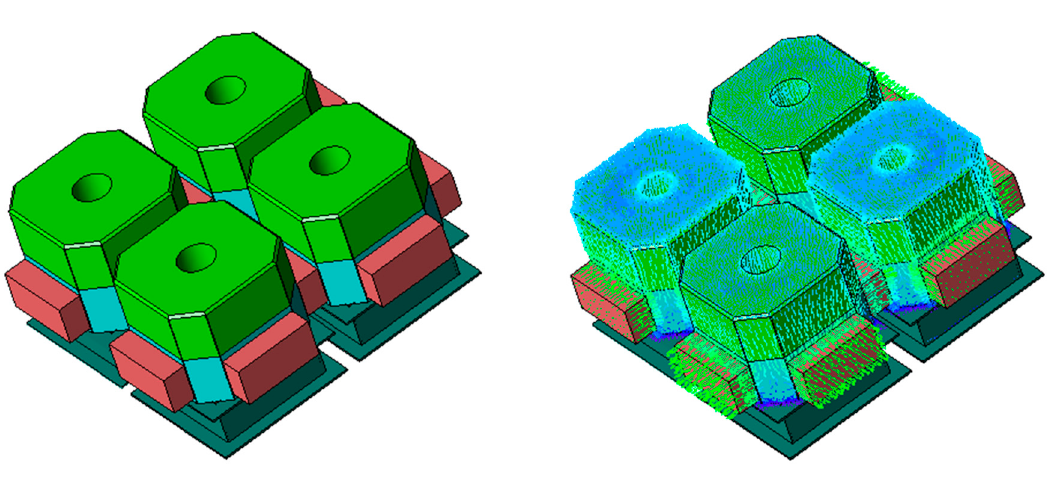
Figure 16. Model showing the polygonal structure applied to both lower and upper cores.